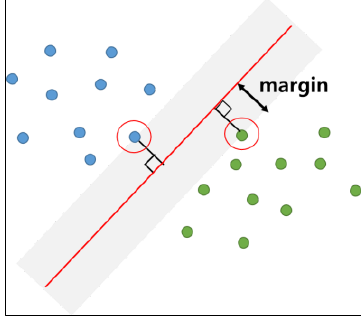
Figure 5. A concept of support vector and margin